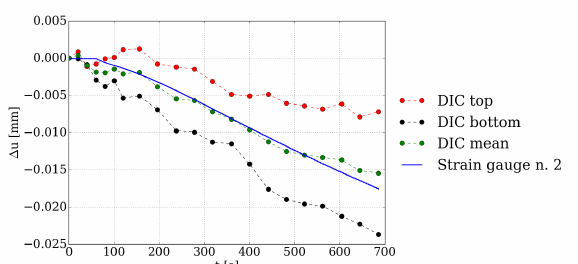
Figure 11: Comparison between the horizontal displacements obtained by the DIC software and the strain gauges measurements for sample n.